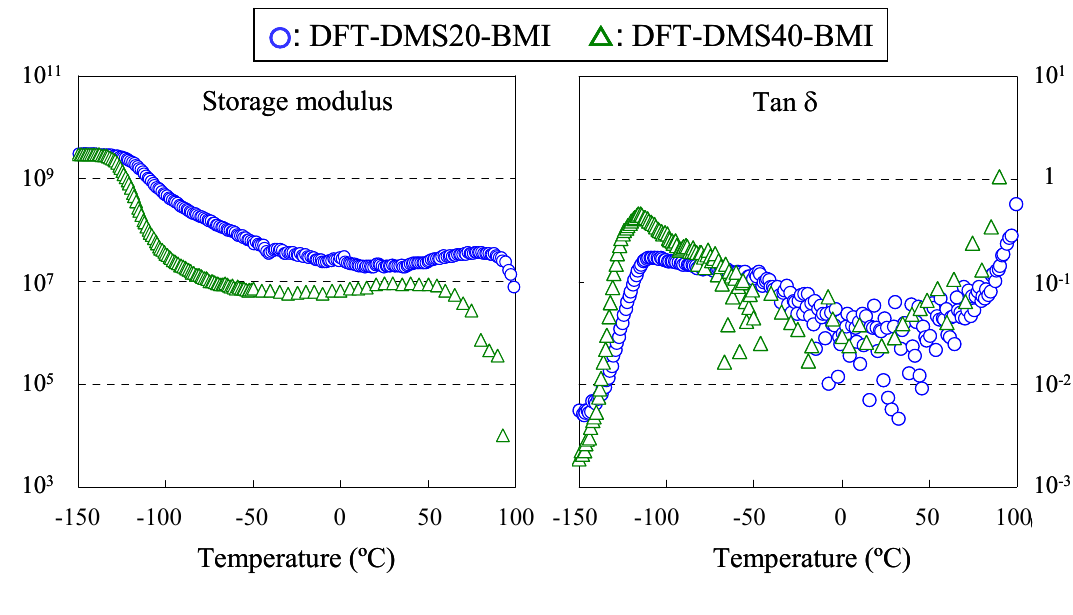
Figure 5. Dynamic mechanical analysis of DFT-DMS20-BMI and